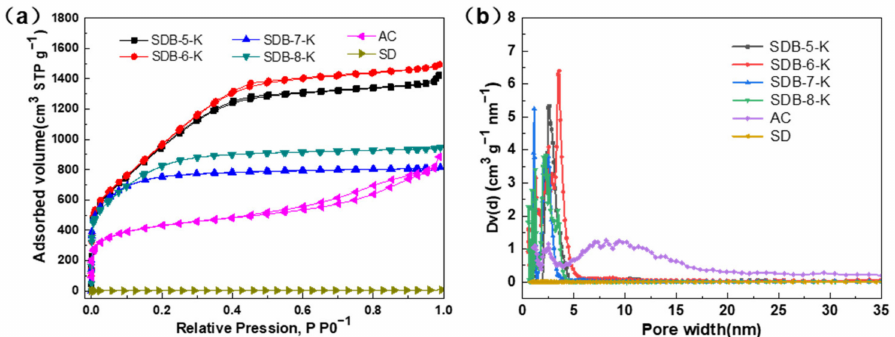
Figure 1. ( a ) N 2 adsorption-desorption isotherms of SDBs-K, AC, and SD; ( b ) pore diameter